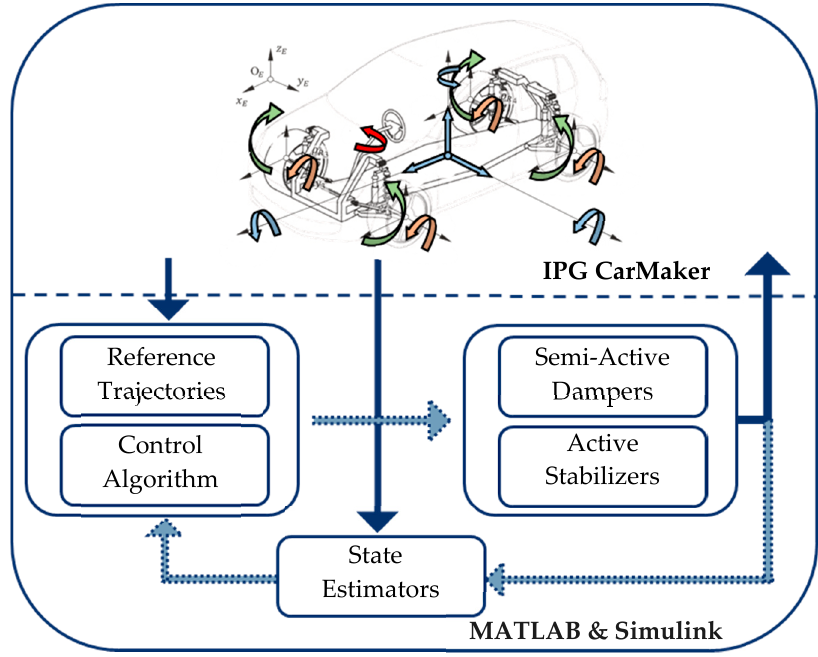
Figure 1. Simulation Framework, © 2021 IEEE. Reprinted, with permission, from [18]. Table 1. Vehicle